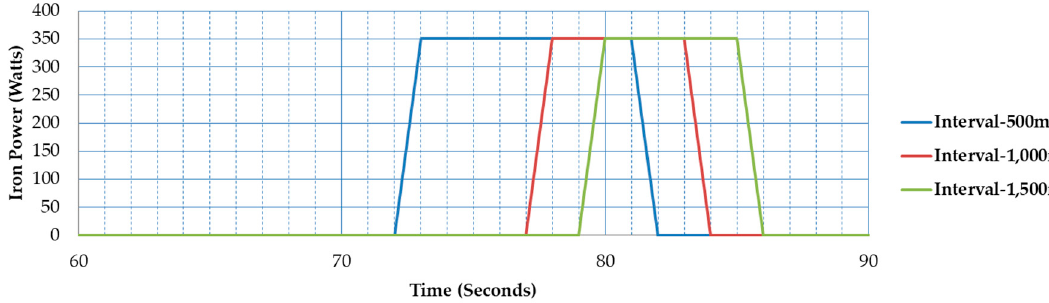
Figure 9. Washing machine power consumption simulated on a 10-s basis.